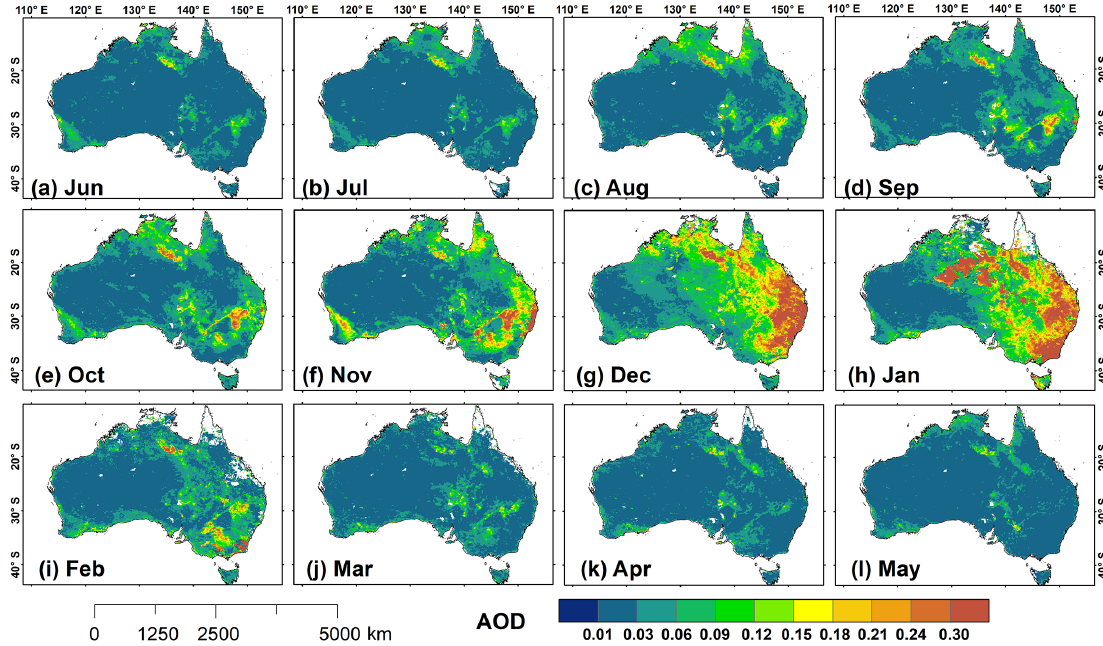
Figure 11. Spatial distributions of monthly averaged Aqua MODIS DB AOD at 550nm over Australia from June 2019 to May 2020.